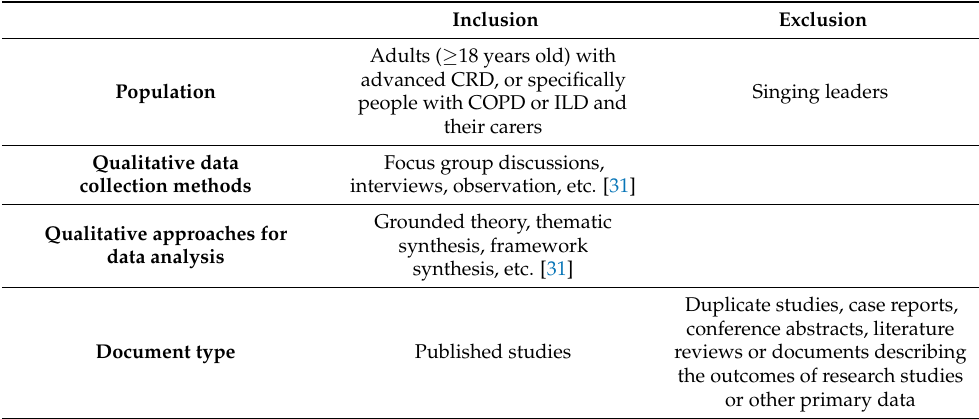
Table 1. Eligibility